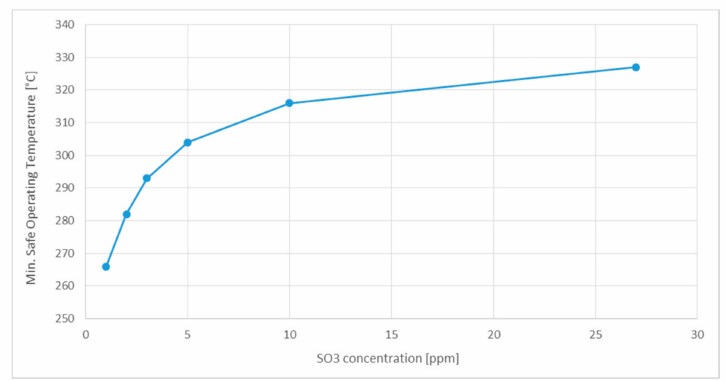
Figure 1. Minimum safe operating temperature for selective catalytic reduction (SCR) reactors as the function of SO 3 concentration, according to Charles